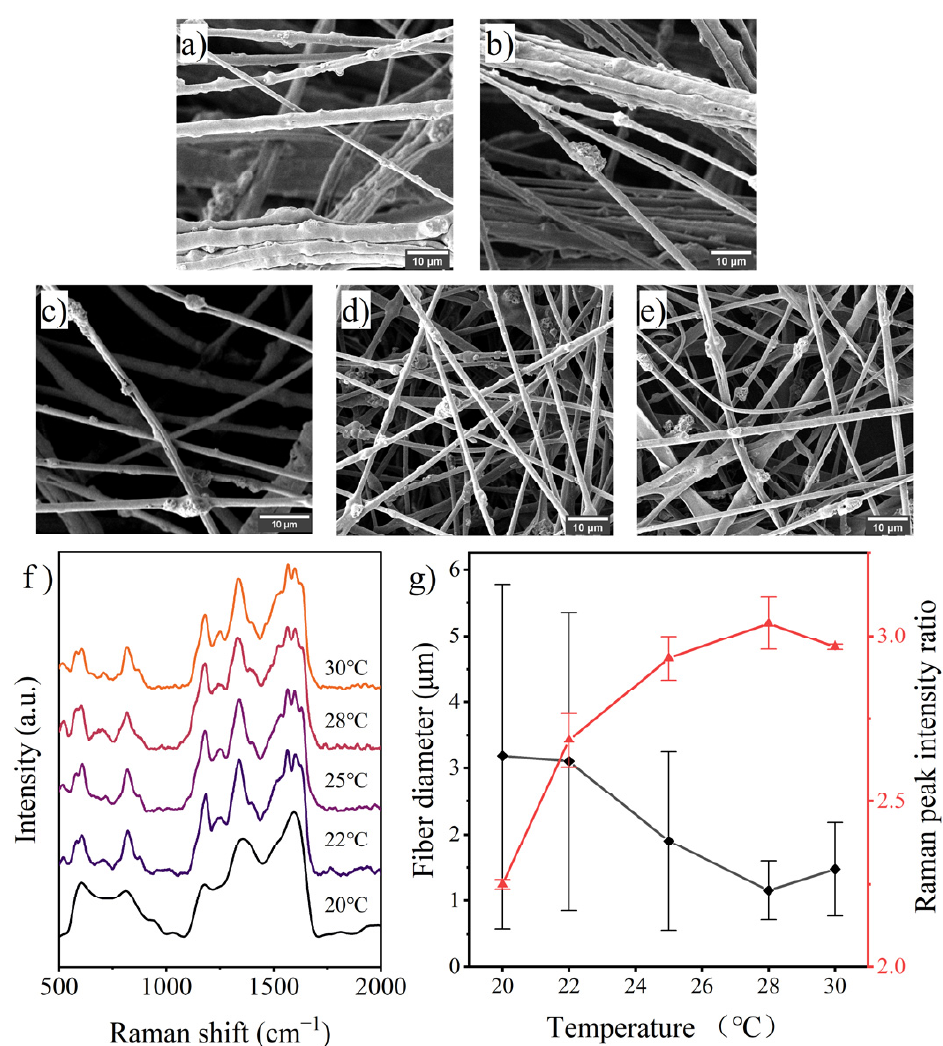
Figure 6. SEM images of fibers prepared with various working temperatures: ( a ) 20 °C, ( b ) 22 °C, ( c ) 25 °C, ( d ) 28 °C, ( e ) 30 °C; ( f ) Raman spectra of the fibers and ( g ) effects of working temperature on fiber diameter and surface PANI occupancy.